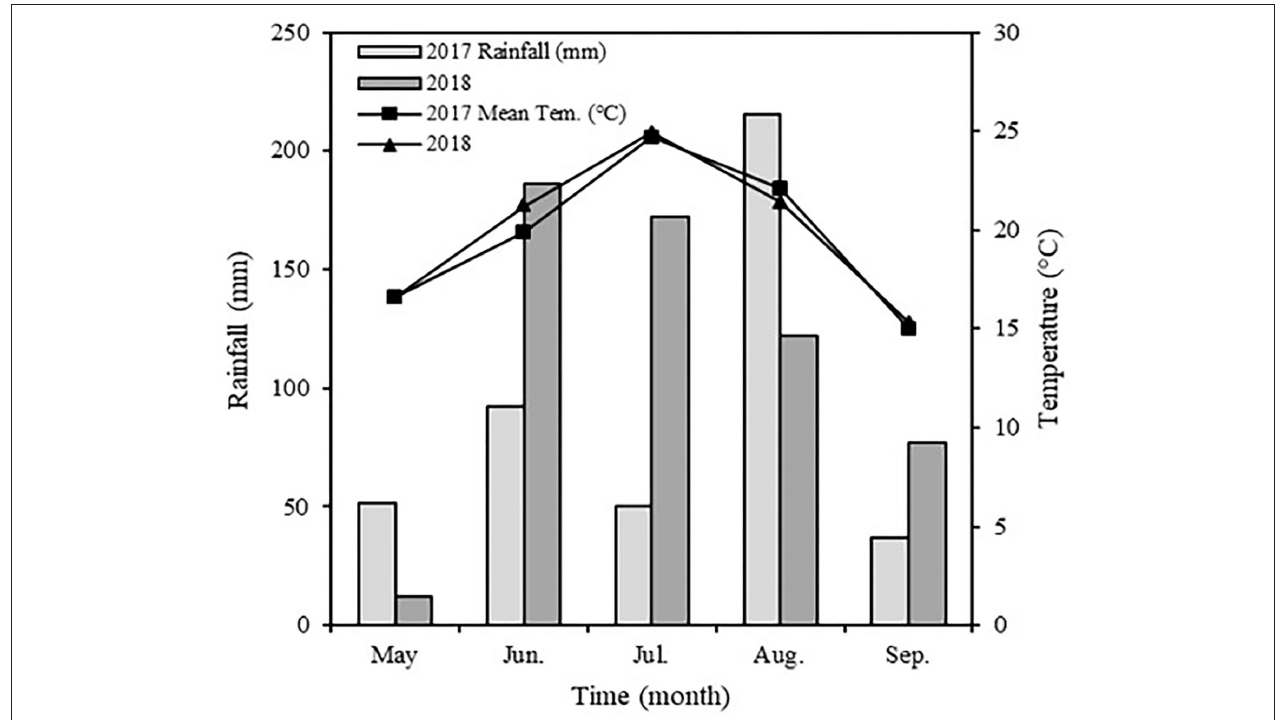
FIGURE 1 | Monthly rainfall distribution and mean temperature during spring maize growing stage in 2017 and